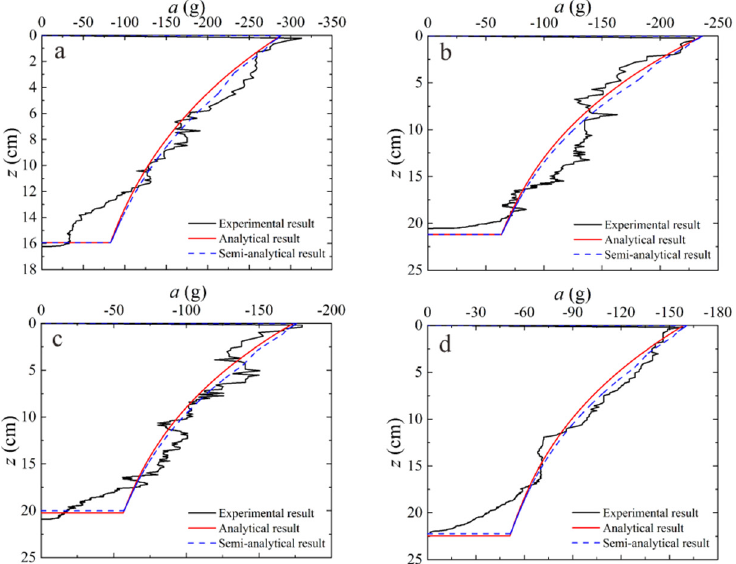
Figure 5. Curves of depth vs. acceleration ( a ) D r = 0.80, V 0 = 22.5 m/s; ( b ) D r = 0.70, V 0 = 23 m/s; ( c ) D r = 0.65, V 0 = 20.1 m/s; ( d ) D r = 0.60, V 0 = 20 m/s.